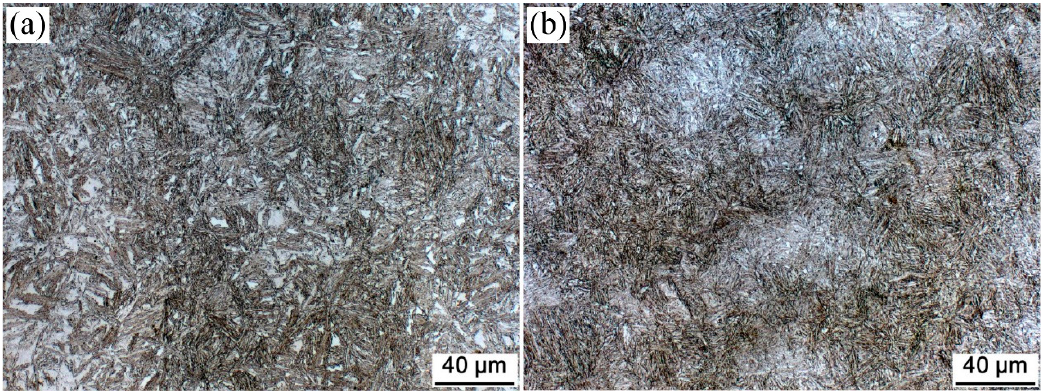
Figure 1. OM micrographs of the investigated steel for ( a ) one-step and ( b ) two-step treatments.